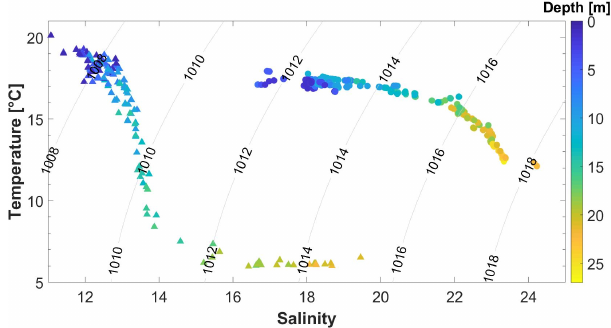
Figure 8. Temperature and salinity diagram of CTD bottle data from June 2018 (triangles) and September 2018 (circles). Grey lines represent the corresponding isopycnals (in kgm − 3 ).